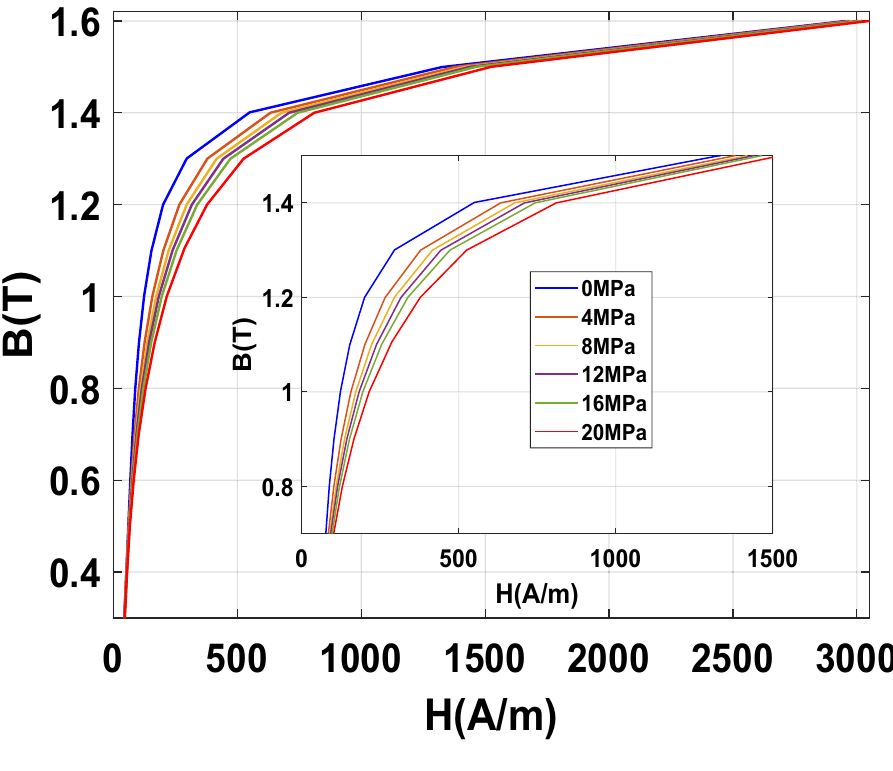
Figure 16. Normal magnetization curves 50 Hz - Homogeneous case.